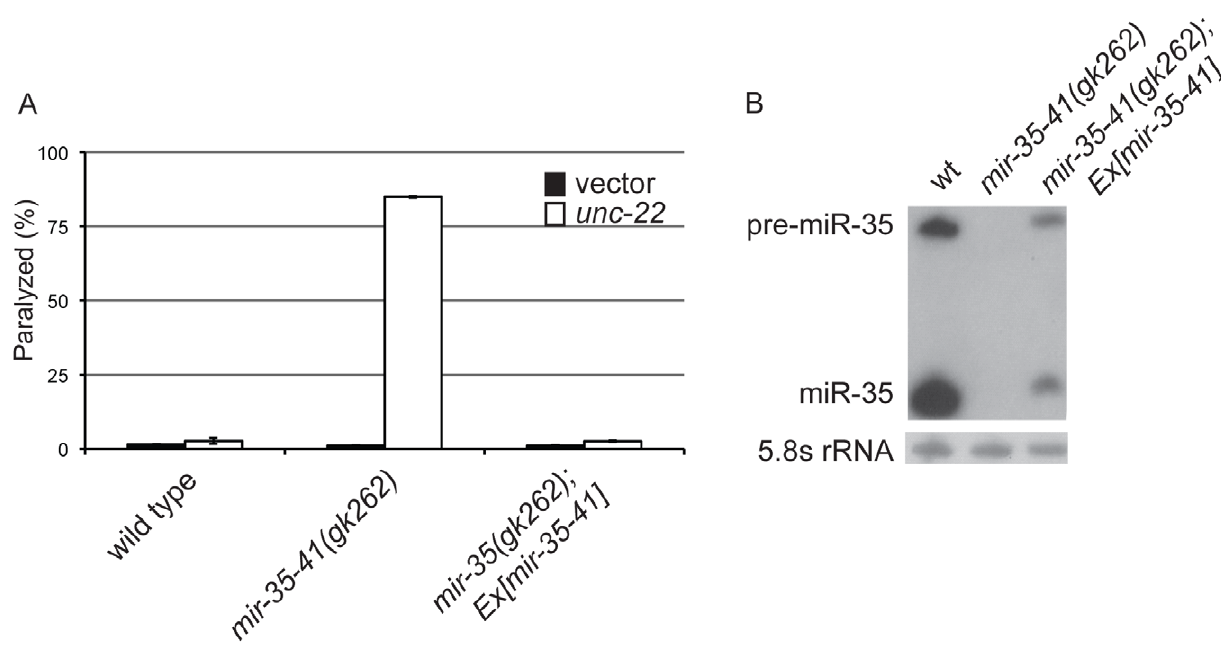
Figure 1. Deletion of the mir-35-41 miRNA cluster results in RNAi hypersensitivity. (A) L4 stage wild type, mir-35-41(gk262) and mir-35- 41(gk262) ; apEx160 [mir-35-41] strains were grown on bacteria expressing unc-22 dsRNA (open columns) or the empty RNAi vector L4440 (black columns). The percentages of paralyzed worms after 28 h of exposure to RNAi conditions are graphed as the mean and standard deviation from three independent experiments. (B) PAGE Northern blot analysis of RNA from wild type, mir-35-41(gk262) and mir-35-41(gk262) ; apEx160 [mir-35-41] embryos shows restored expression of precursor and mature mir-35 miRNA in the transgenic strain. 5.8S rRNA levels are shown as loading controls.